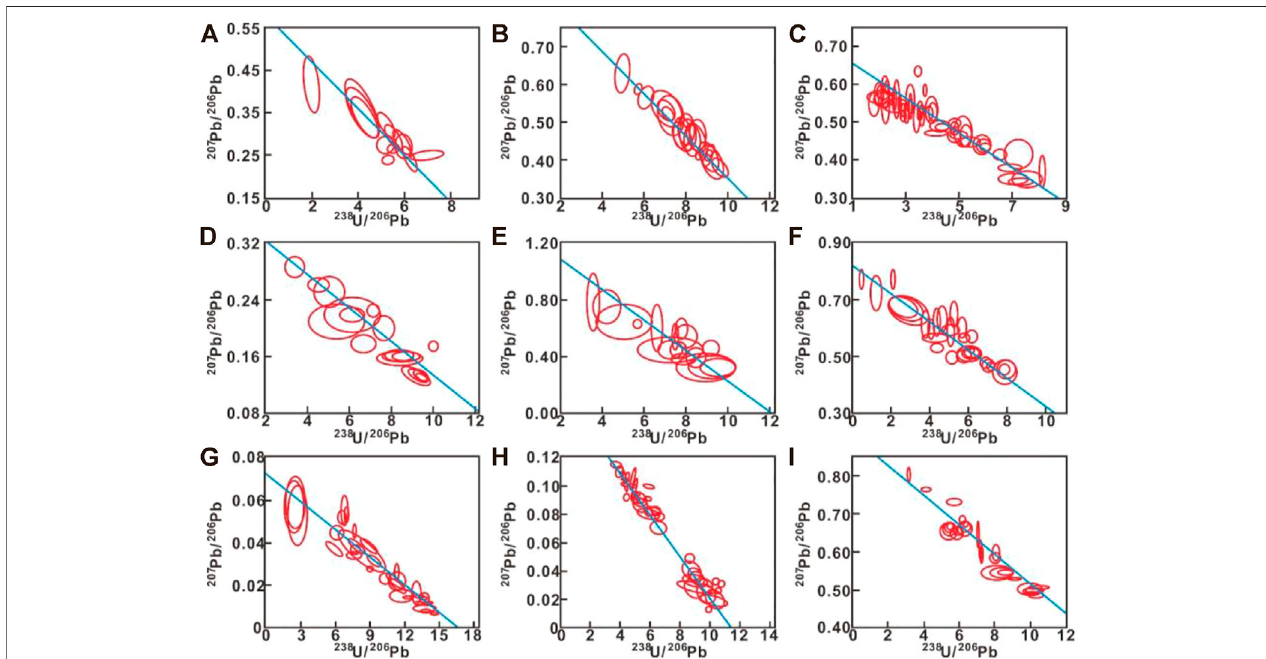
FIGURE 8 | U-Pb ages from carbonate minerals using LA-ICP-MS method. (A) Fine-sized dolomite, age of 494 ± 12 Ma. (B) Fine-sized dolomite, age of 498 ± 36 Ma. (C) Dolomitic microbialite, age of 474 ± 31 Ma. (D) Dolomitic microbialite, age of 480 ± 12 Ma. (E) Dolomitic microbialite, age of 477 ± 12 Ma. (F) Dolomite